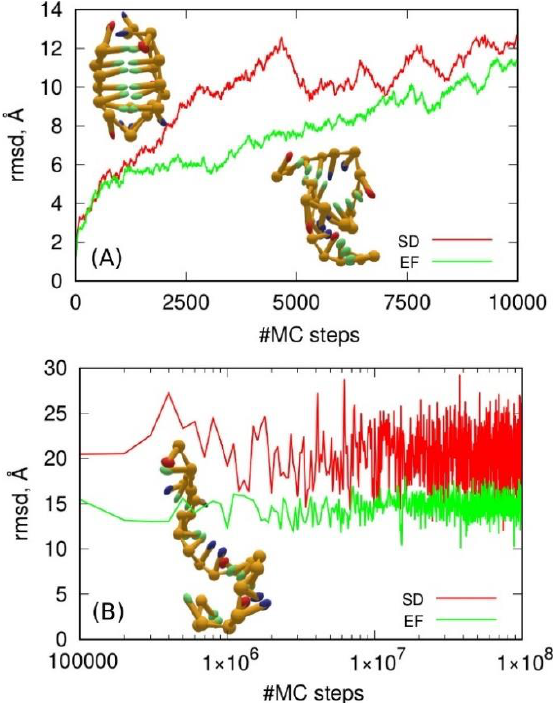
Figure 6. Root-mean-square displacement (rmsd) of the analyzed sequences from the initial i-motif structure obtained using Monte Carlo simulations according to the oxDNA2 model. ( A ) The initial stage up to 10,000 MC steps using the two approaches to base pairing, i.e., SD — sequence-dependent approach and EF — mutual traps between C:C + pairs. Part ( B ) The whole simulation involving 10 8 MC steps. The inset in ( B ) shows the final structure after 10 8 steps for the SD approach, while the inset on the right of ( A ) shows the final structure obtained from EF approach. The rmsd values were calculated using the ideal i-motif structure (inset on the left of ( A )) as a reference, and each configuration was aligned and best-fitted to the initial configuration. The trajectories of the oxDNA simulation were remapped into cartesian coordinates of the center of mass of the backbone and base beads using the tool traj2xyz.py provided in the oxDNA distribution package.